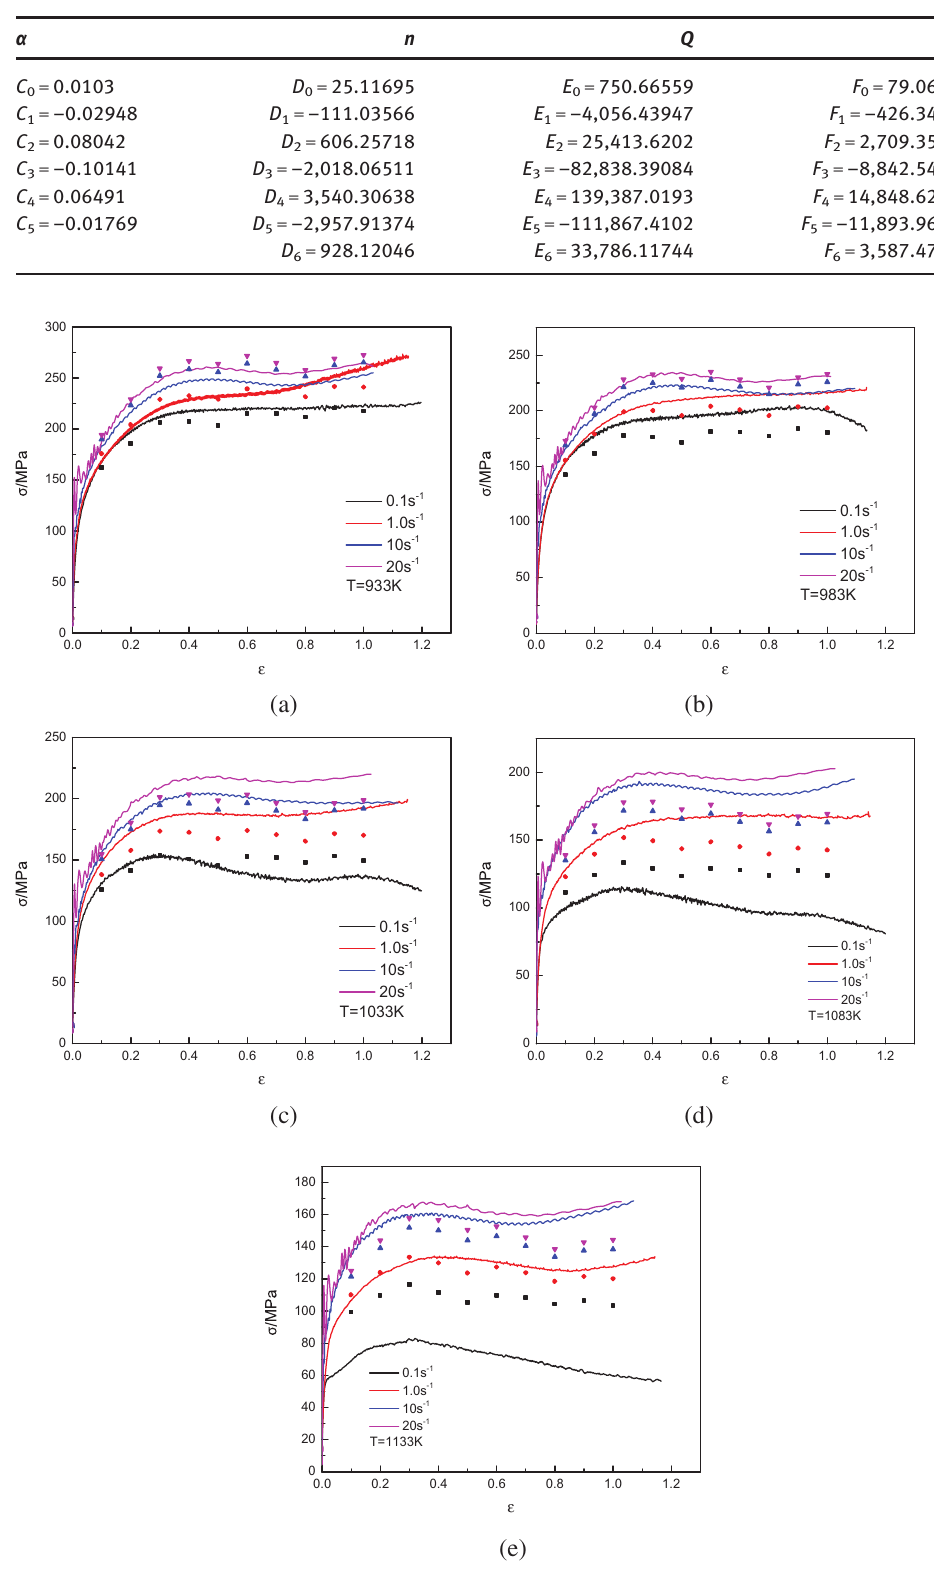
Figure 20: Comparison between experimental and predicted flow stress using strain-compensated Arrhenius-type equation at the tem- peratures of (a) 933 K, (b) 983 K, (c) 1,033 K, (d) 1,083 K, (e) 1,133